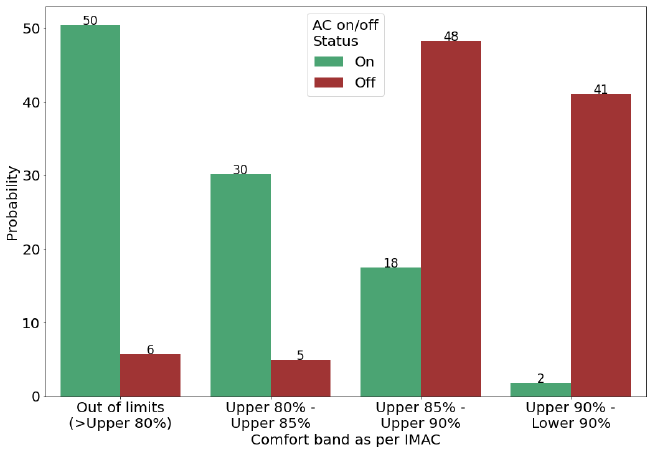
Figure 8. AC on/off probability within various IMAC comfort bands.